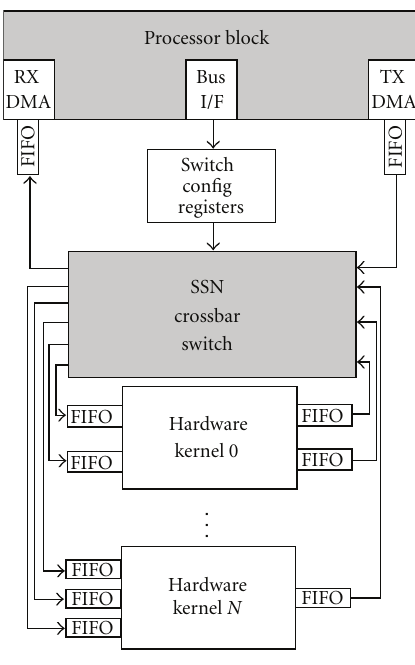
Figure 5: Stream switch network.